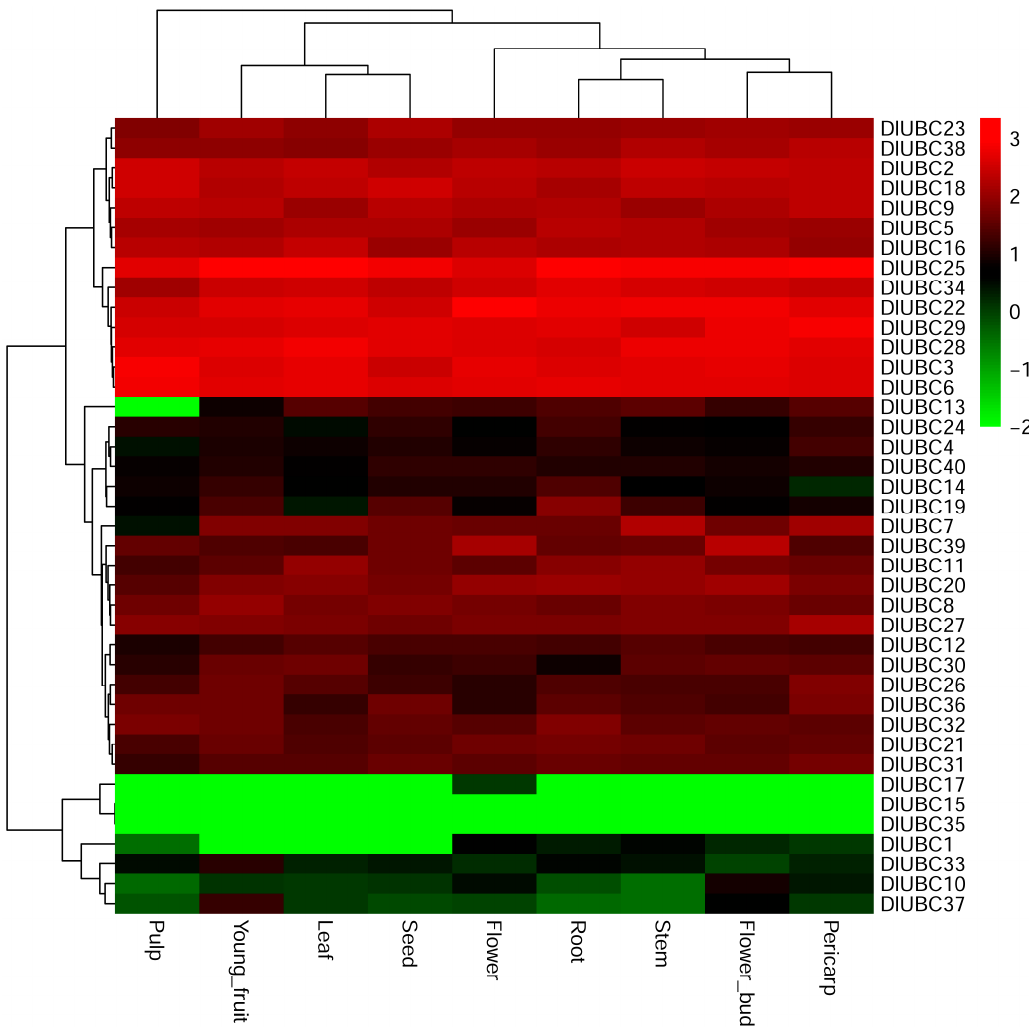
Figure 3. Expression profiles of DlUBC genes across different tissues and developmental stages in longan. Heat map of the hierarchical clustering of 40 UBC genes across different tissues analyzed in this study. The color scale represents log 10 expression values; red and green colors indicate lower or higher transcript abundance compared to the relevant control, respectively.